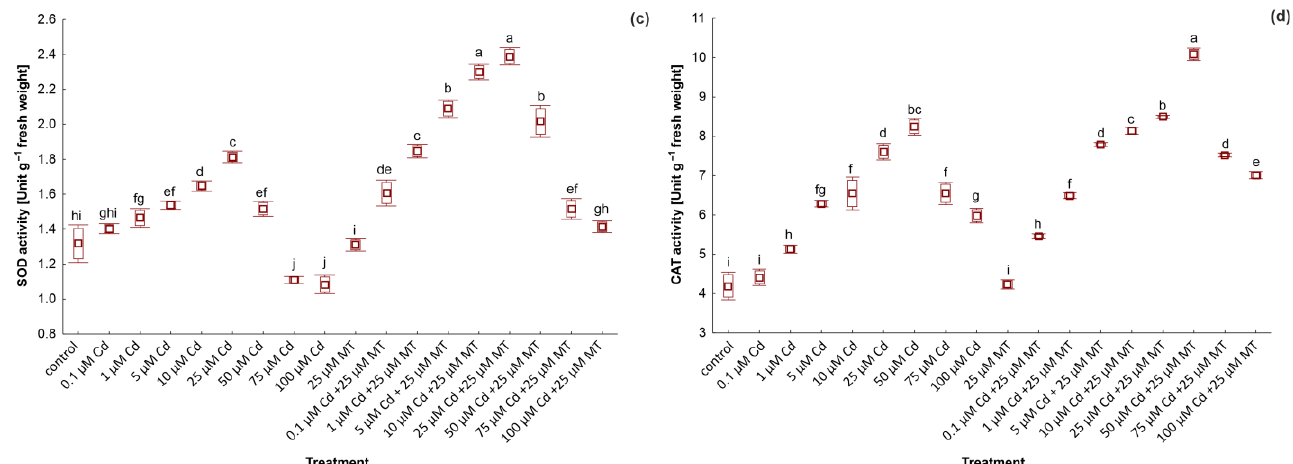
Figure 6. The activity of ascorbate peroxidase (APX) ( a ), glutathione reductase (GR) ( b ), superoxide dismutase (SOD) ( c ), and catalase (CAT) ( d ) in W. arrhiza exposed to cadmium (Cd) and/or melatonin (MT) after 7 days of cultivation. The square represents the mean ( n = 5, biological replicate). The lower and upper hinges correspond to the lower and upper bounds of the 95% confidence interval of the means. The lower and upper whiskers extend from the hinge to the mean ± standard deviation. Means with the same letters are not significantly different ( p ≥ 0.05) according to Tukey’s post hoc test .